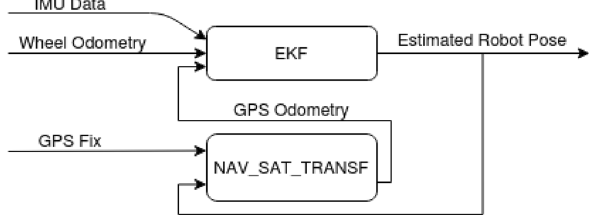
Fig. 5 Diagram illustrating the EKF-based sensor fusion technique. The filter is composed of two nodes. The EKF node uses Odometry and IMU type ROS messages and fuses them together in a custom- ized way (for example, based on the weight defined for each meas- urement). The NAV-SAT-TRANSF node transforms the GPS data mes- sage into an Odometry type message that is consistent with